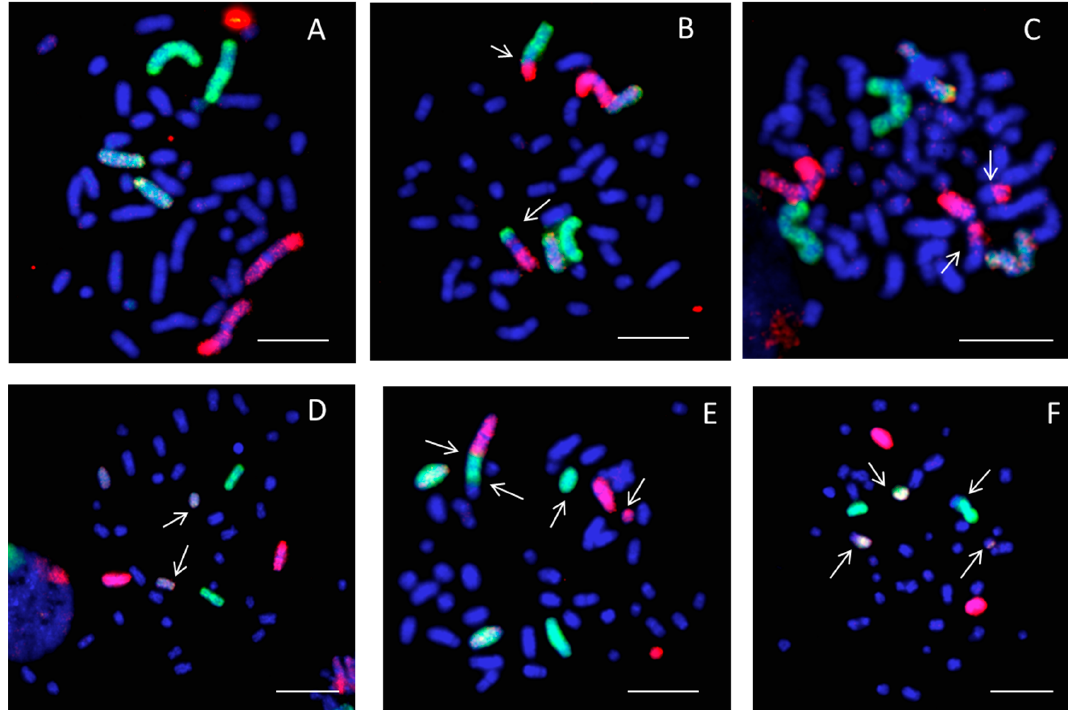
Figure 2. Examples of chromosome painting in human fibroblasts (1BR-hTERT) with 3-color whole-chromosome FISH: chromosome 1 (red), chromosome 2 (green), and chromosome 4 (yellow). Chromosome aberrations were identified by arrows as simple (reciprocal exchanges between two chromosomes) or complex-type exchanges (exchanges involving a minimum of three breaks in two or more chromosomes). A : normal; B : simple exchange between chromosome 1 and 2; C : simple exchange between chromosome 1 and other chromosome (dicentric); D : break in chromosome 4 complex; E : complex exchange in chromosomes 1 and 2 and another chromosome; F : complex exchange in chromosomes 2 and 4 and another chromosome). The scale bars represent 10 µ m. Table 1. Whole-genome equivalent for frequency of chromosome aberrations per 100 cells in human fibroblasts by X-ray and C-ion beam under static and simulated µ G conditions. Radiation Control (0 Gy) Radiation X-ray (0.5 Gy) X-ray (1.5 Gy) C-ions (0.5